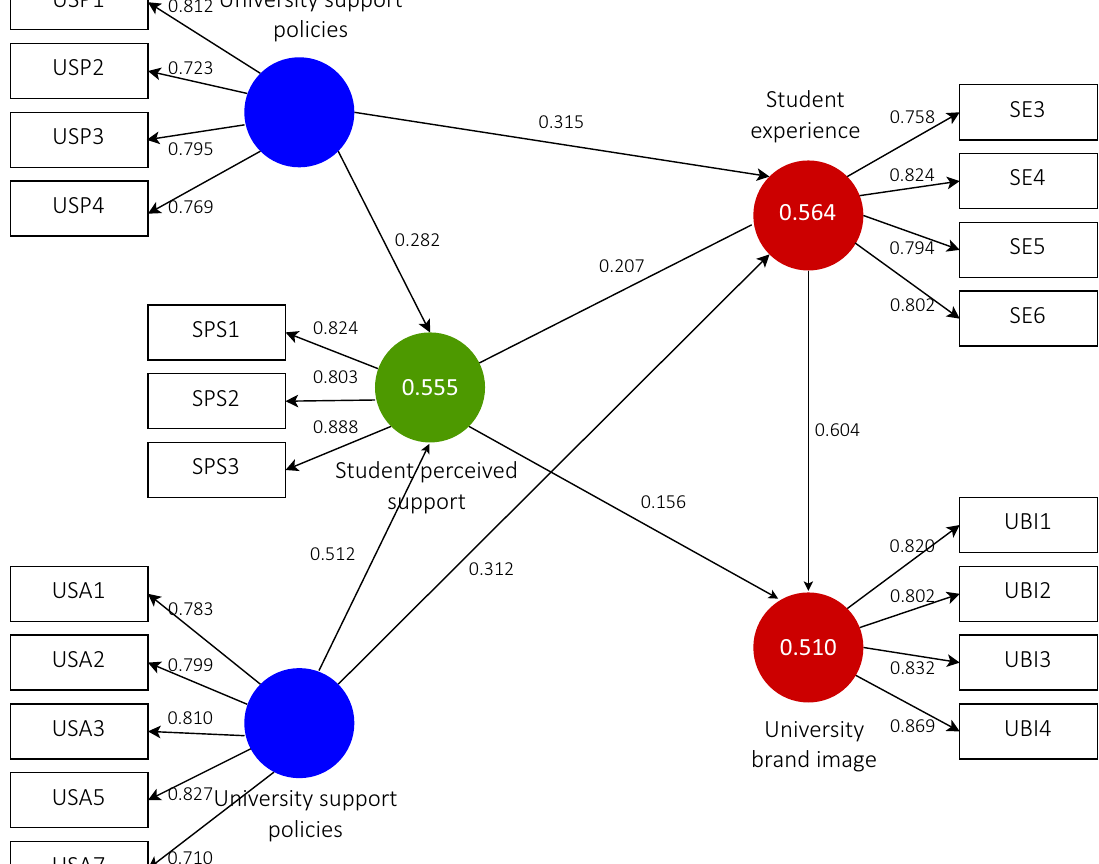
Figure 2. Modeling results